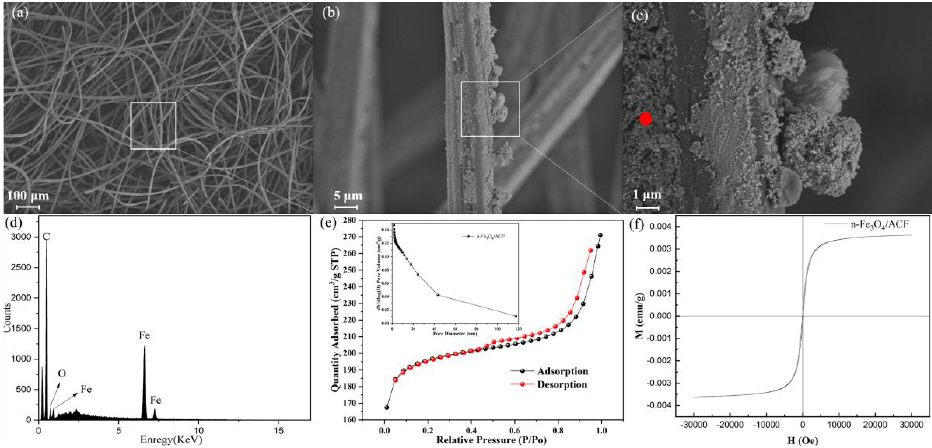
Figure 1. ( a – c ) SEM image of n-Fe 3 O 4 /ACF at different magnifications; ( d ) EDS energy spectra of Figure 1 ( c )-labeled region; ( e ) N 2 adsorption isotherm curve and pore size distribution curve of n-Fe 3 O 4 /ACF; ( f ) VSM of n-Fe 3 O 4 /ACF.